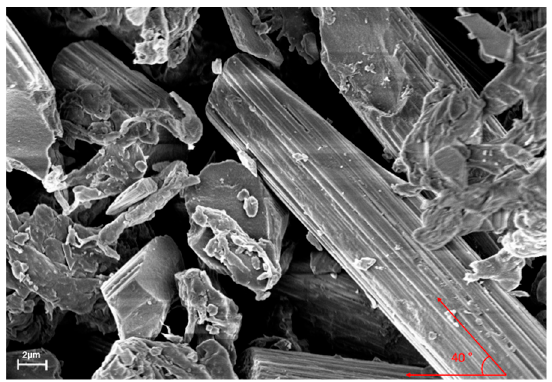
Figure 1. Orientation angle of carbon fibre at 40°.